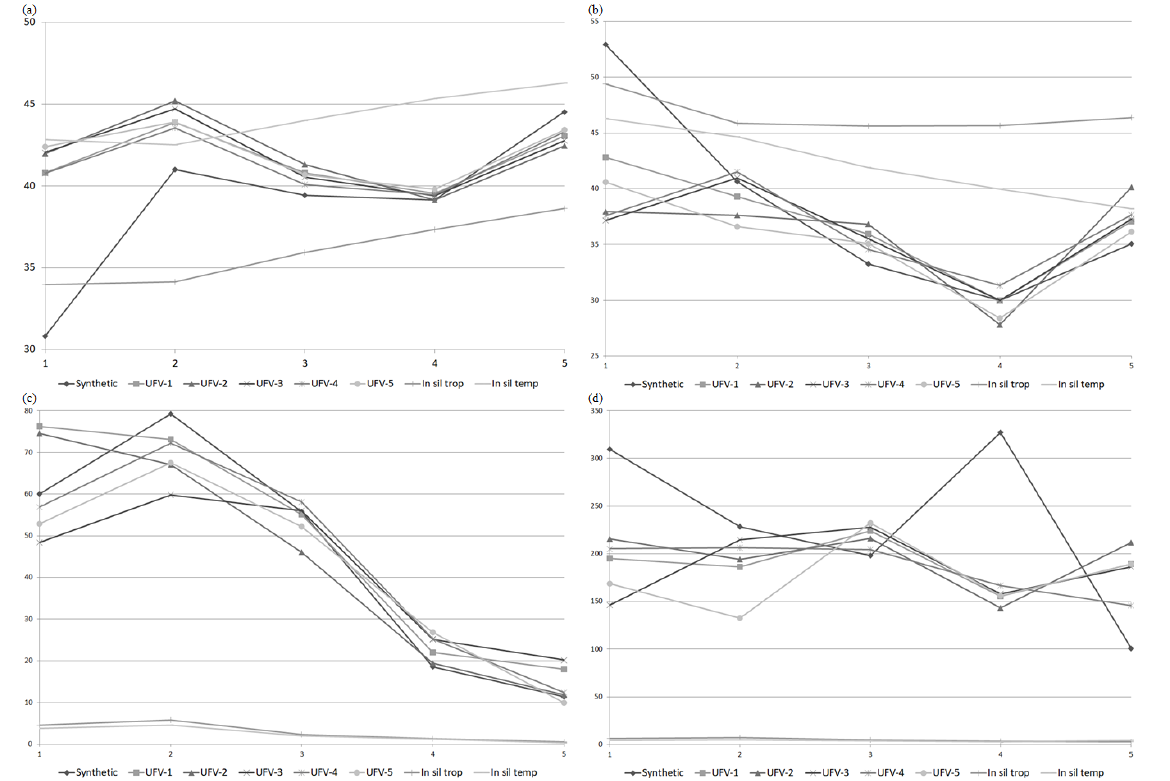
Figure 2. Changes in the populations means ( a , b ) and variances ( c , d ) over generations (S 0 = 1) with pedigree-based BLUP, using the predicted or true additive (for the in silico populations) values in the generations S 1 , S 2 , and S 3 , relative to EV (( a , c ); mL/g) and grain yield (( b , d ); g/0.18 m 2 ).